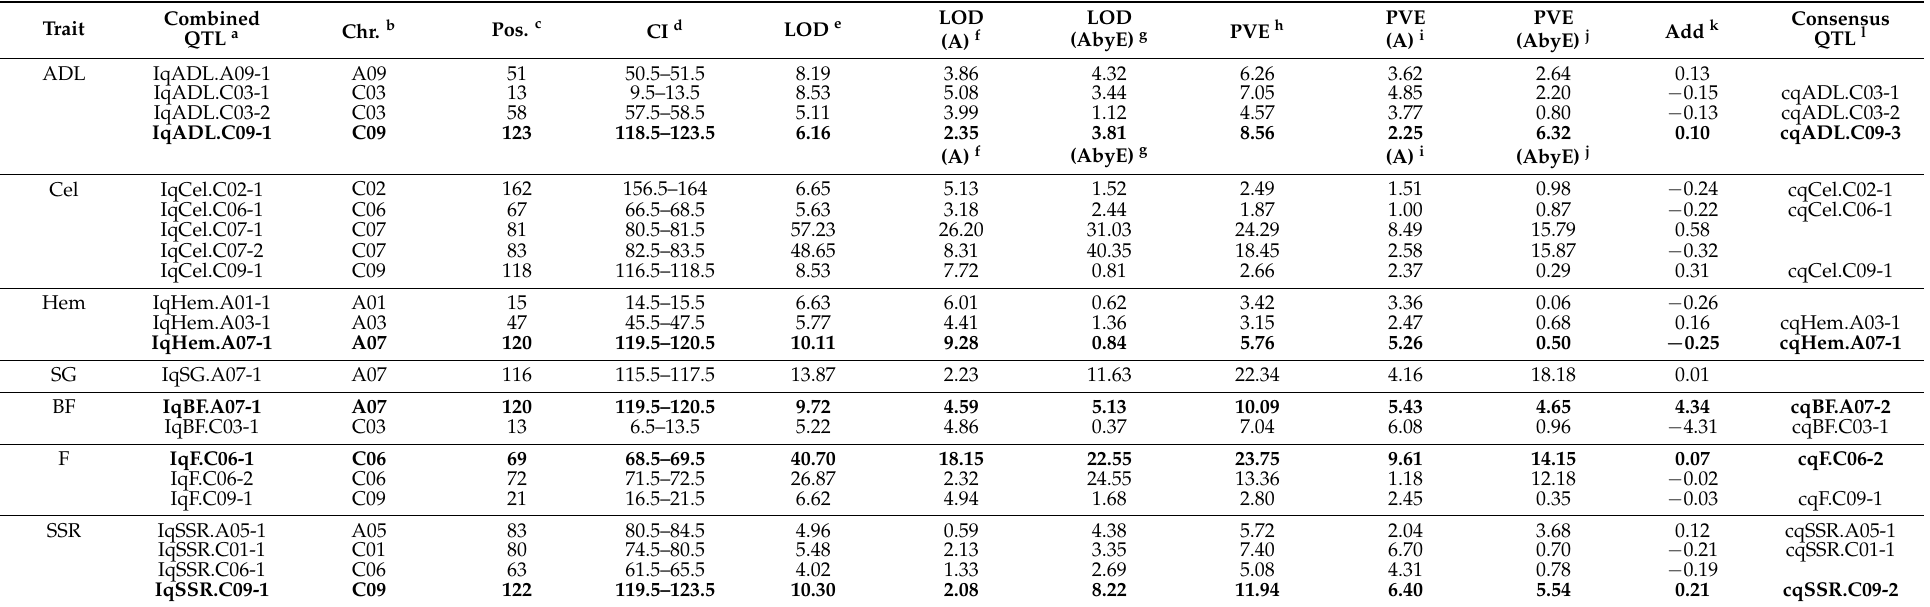
Table 4. Summary of the combined QTL detected by QEI